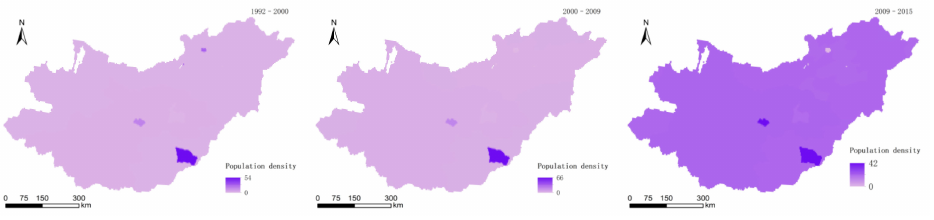
Figure 9. Population density changes in 1992–2000, 2000–2009, 2009–2015. The raster data obtained above needed to be standardized, that is, the projections needed to be uniformly converted into WGS-84, UTM49N, and the raster size was set to 100 m × 100 m.